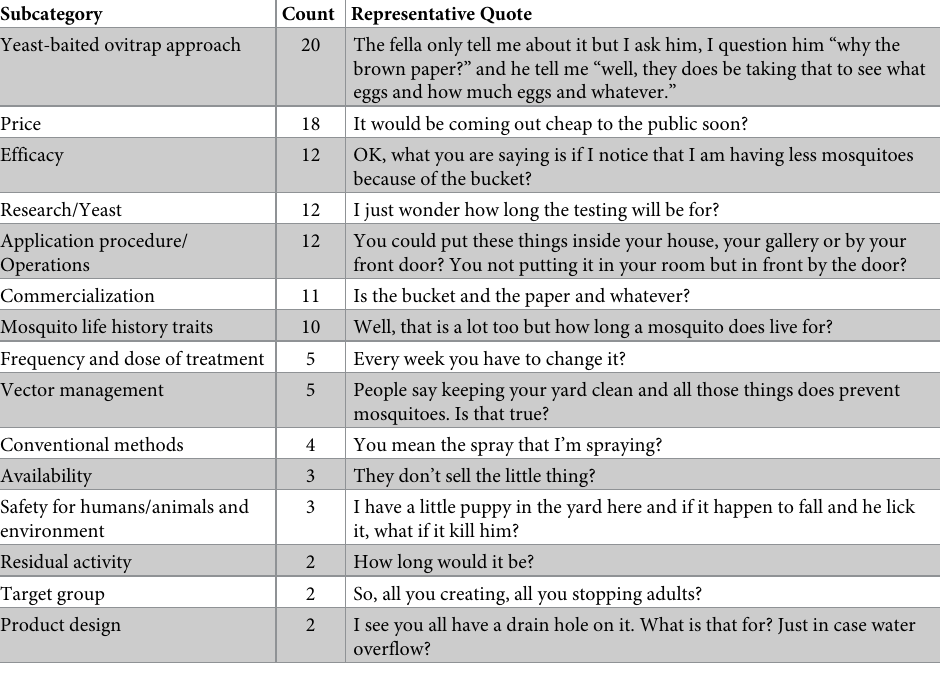
Table 6. Common categories of information gathering questions posed by the interviewees. Subcategory Count Representative Quote